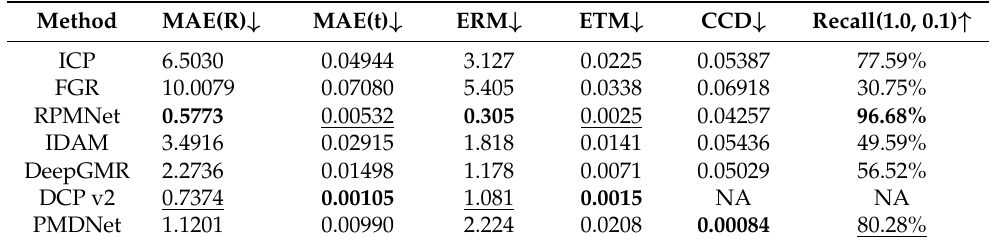
Table 7. Results on Gaussian noise data. Bold and underline denote best and second best performance.